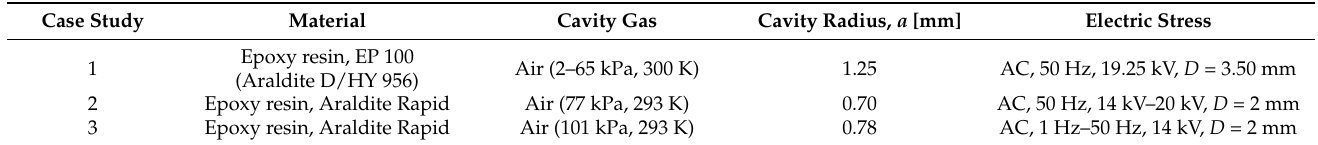
Table 1. Description of the materials and applied electric stress in the case